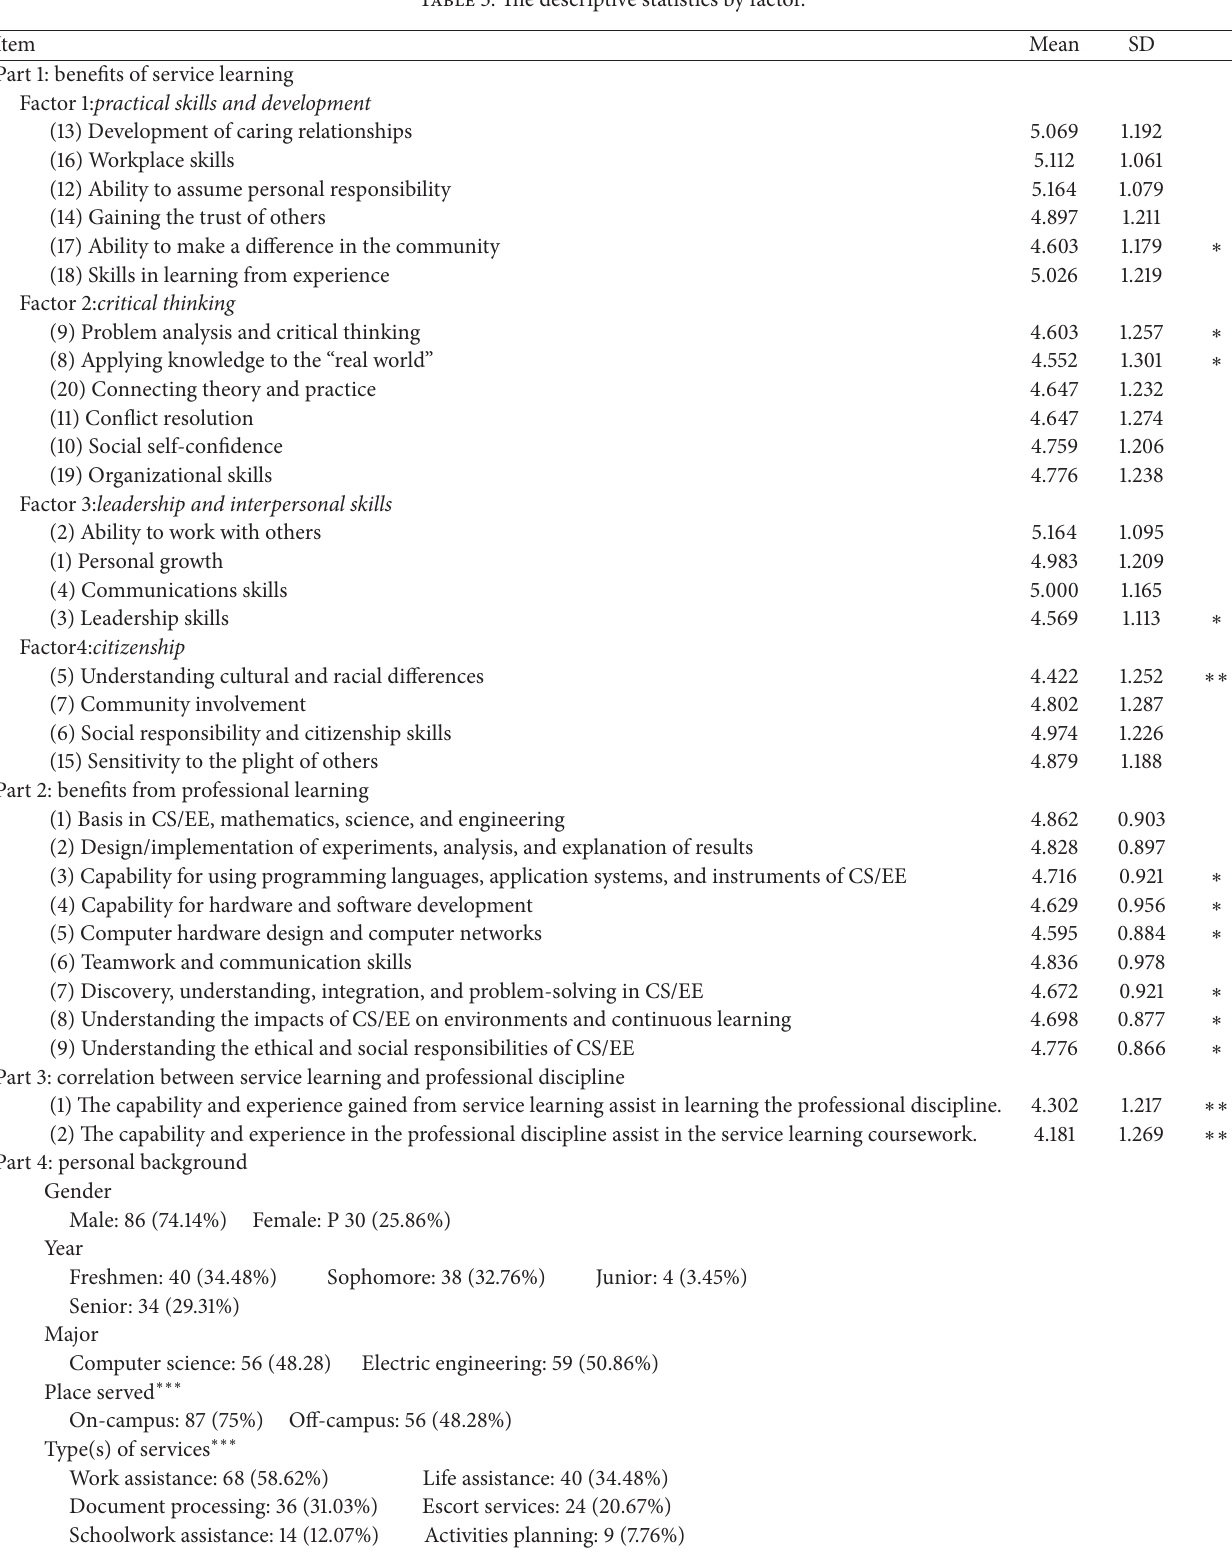
Table 3: The descriptive statistics by